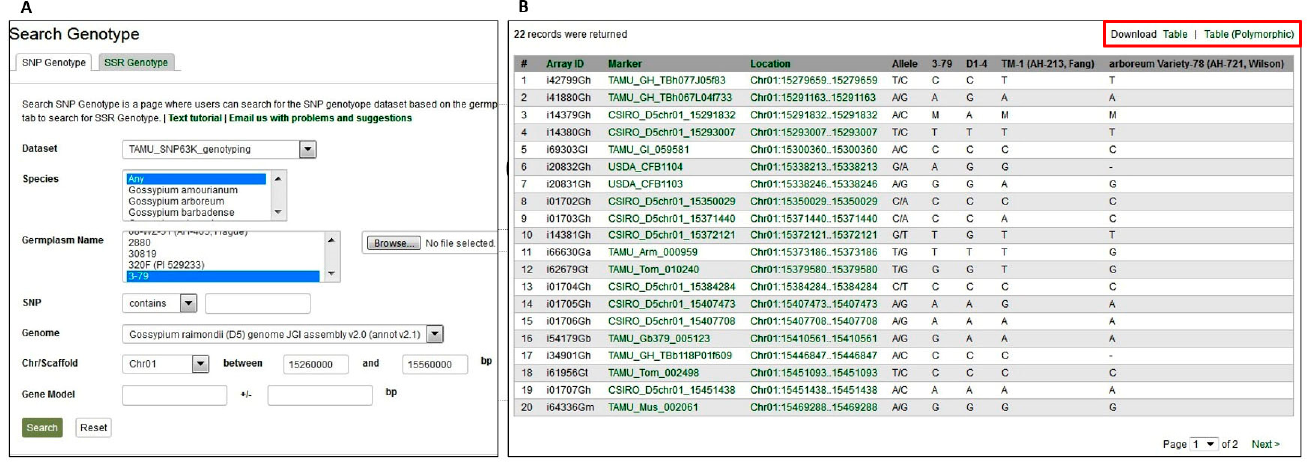
Figure 2. SNP Genotype search page in CottonGen. ( A . left) Researchers can search SNP genotype data by dataset name, species, germplasm name, SNP name, genome location, and/or gene name. Researchers can also upload a file with a list of germplasm names. ( B . right) Search result table that shows SNP name, genome location, allele, and the genotype data of all the germplasm chosen in the order of SNP location in the genome. The red square highlights the options to download the genotype for all the markers displayed in the result page or the genotype data that are polymorphic in the germplasm set chosen.